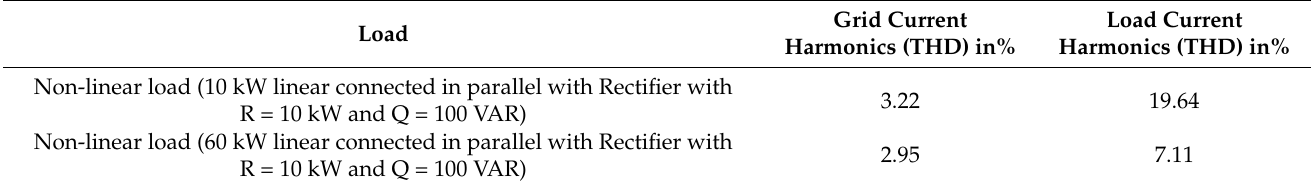
Table 5. Comparative analysis for different loads.